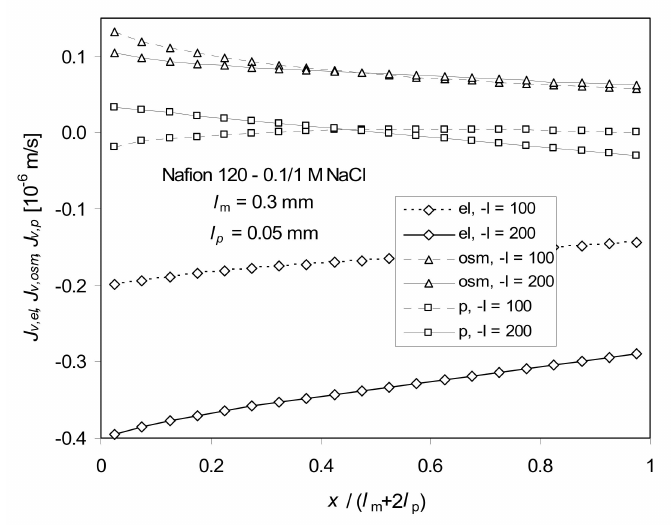
Figure 4. Profiles of electroosmotic (el), osmotic (osm), and pressure-driven (p), components of J v calculated from Equation (5) (full ITE) for the current density – I = 100 and 200 A / m 2 ; one can notice a dominant role of electroosmotic contribution to J v at higher current density.